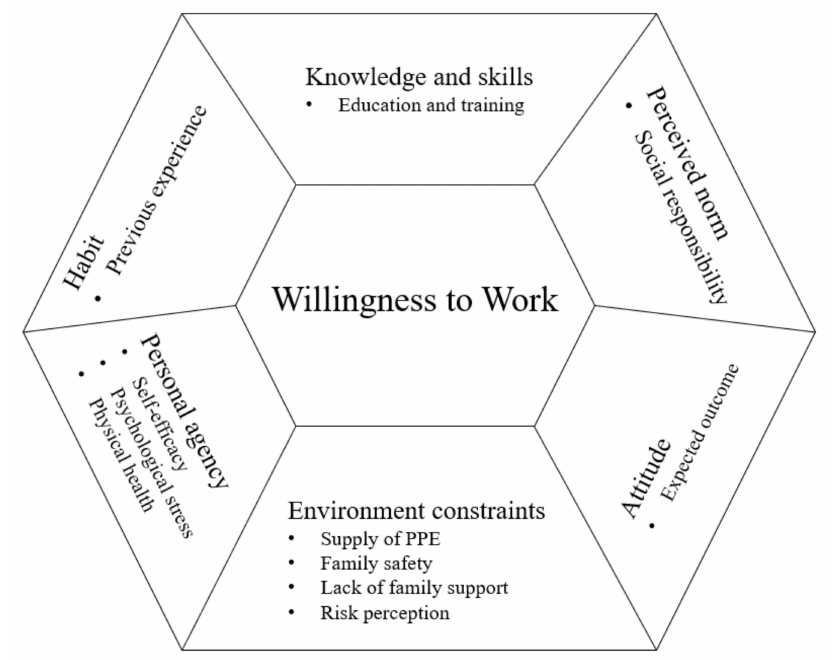
Figure 2. Barriers and Facilitators of Nurses and Physicians’ Willingness to Work During a Respira- tory Disease